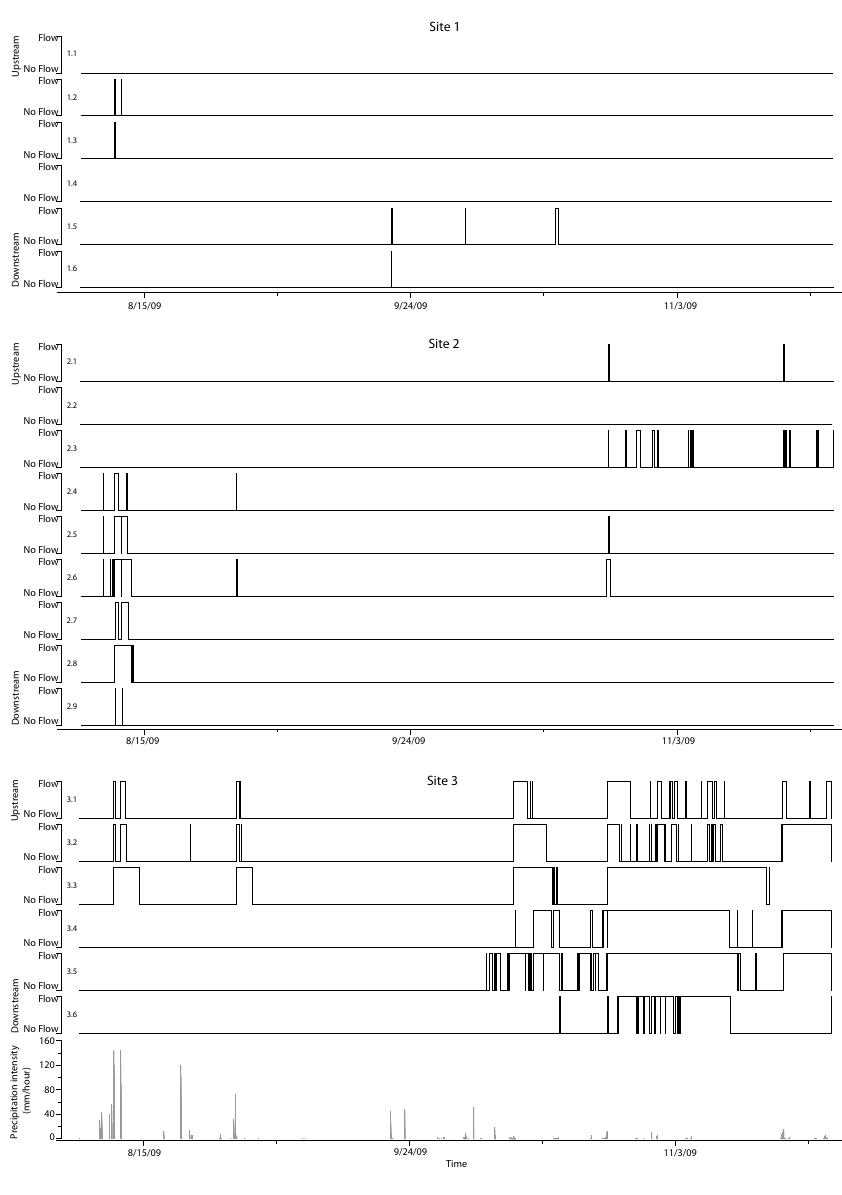
Fig. 7. Final flow data from field with noise removed